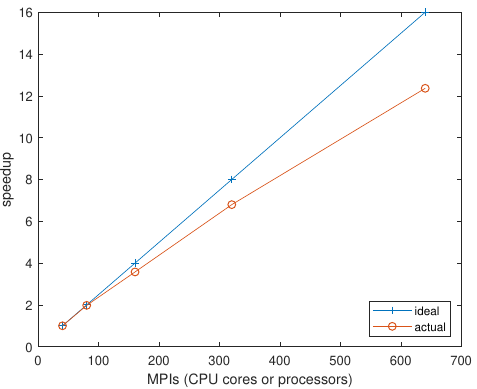
Figure 13. The speedup for the unknown endpoint example with 640 ensemble